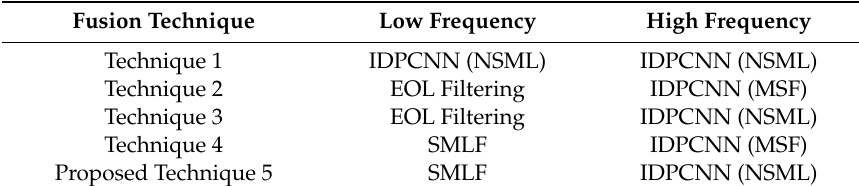
Table 5. Combination method of low and high frequency fusion criteria.